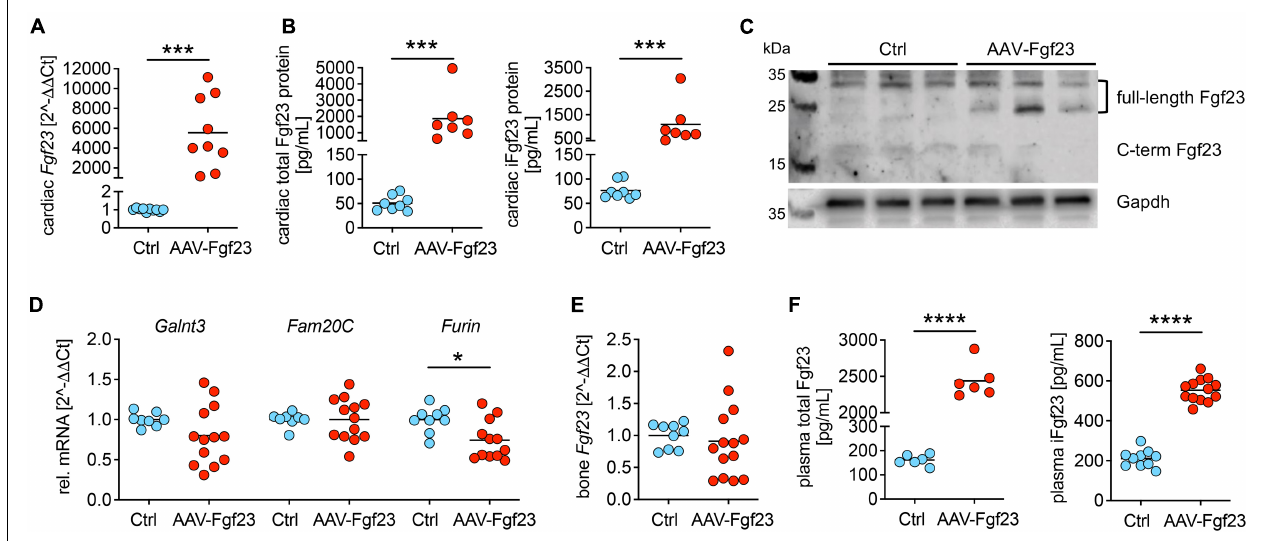
FIGURE 2 | Myocardial gene transfer of AAV-Fgf23 causes cardiac-specific Fgf23 overexpression resulting in the synthesis of intact Fgf23 protein. (A) Relative cardiac Fgf23 mRNA expression increases in AAV-Fgf23 mice compared to Ctrl. (B) ELISA-based quantification of cardiac Fgf23 protein in heart tissue lysates shows increased total and intact Fgf23 (iFgf23) protein in AAV-Fgf23 mice compared to Ctrl. (C) Representative immunoblotting of Fgf23 in cardiac tissue of three mice each demonstrates increased iFgf23 protein in AAV-Fgf23 mice compared to Ctrl, whereas C-terminal fragments are slightly reduced. Gapdh serves as the loading control. (D) Relative mRNA expression of Galnt3 and Fam20C is unchanged in AAV-Fgf23 mice compared to Ctrl, while Furin transcription is significantly reduced. (E) Fgf23 mRNA expression in the bone is similar between AAV-Fgf23 and Ctrl mice. (F) Plasma C-term and iFgf23 levels are significantly enhanced in AAV-Fgf23 mice compared to Ctrl. Data are given as scatter dot plots with means; * p < 0.05, *** p < 0.001, and **** p < 0.0001 analyzed using unpaired t -test or Mann–Whitney test according to Shapiro–Wilk normality test; n = 6–14 mice per